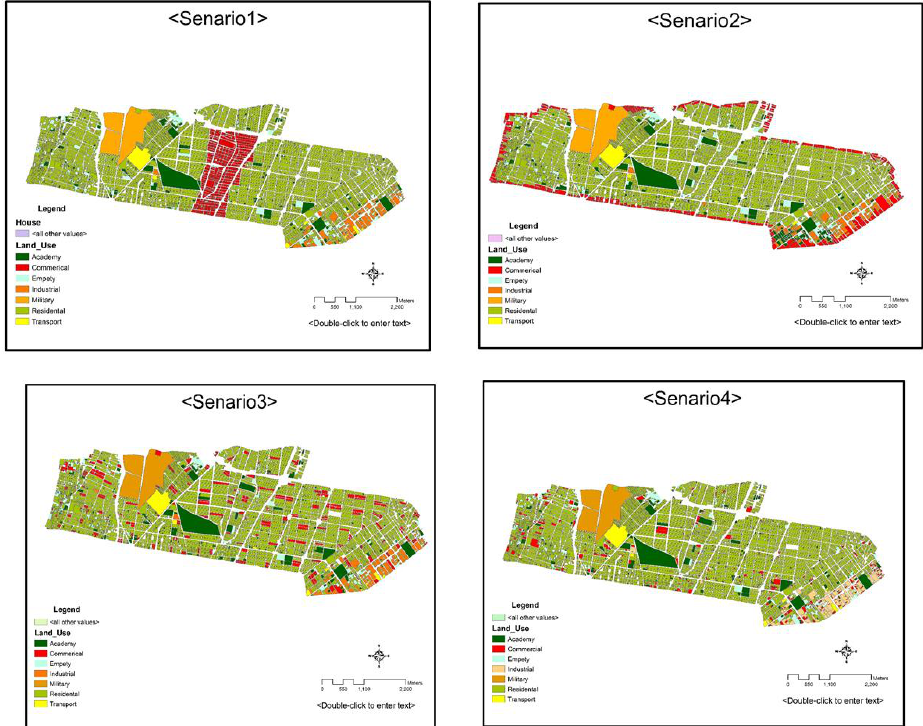
Fig. 6. Displays all scenarios and different service layout (Parcels with red color are land use service).